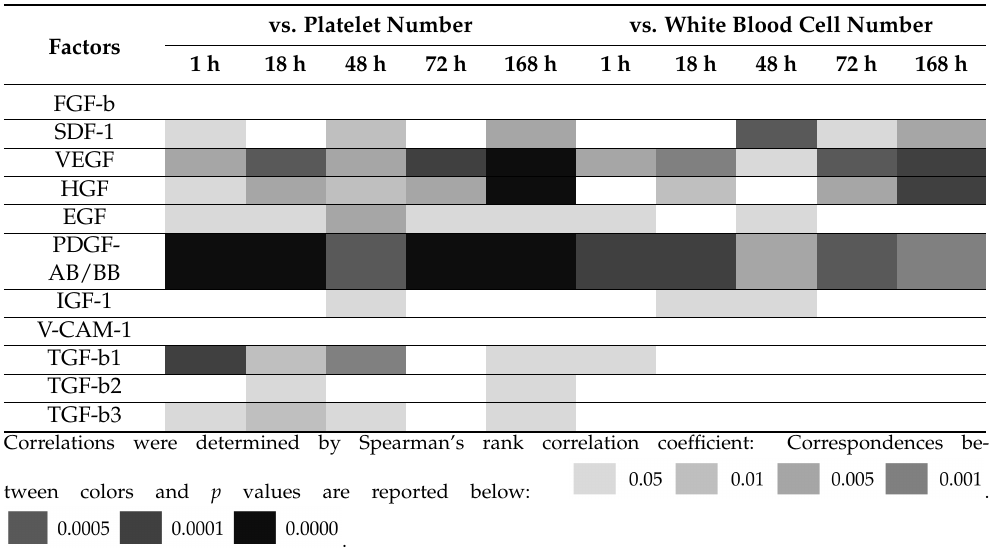
Table 2. Correlations between growth factor concentration and platelet or white blood cell number at different incubation